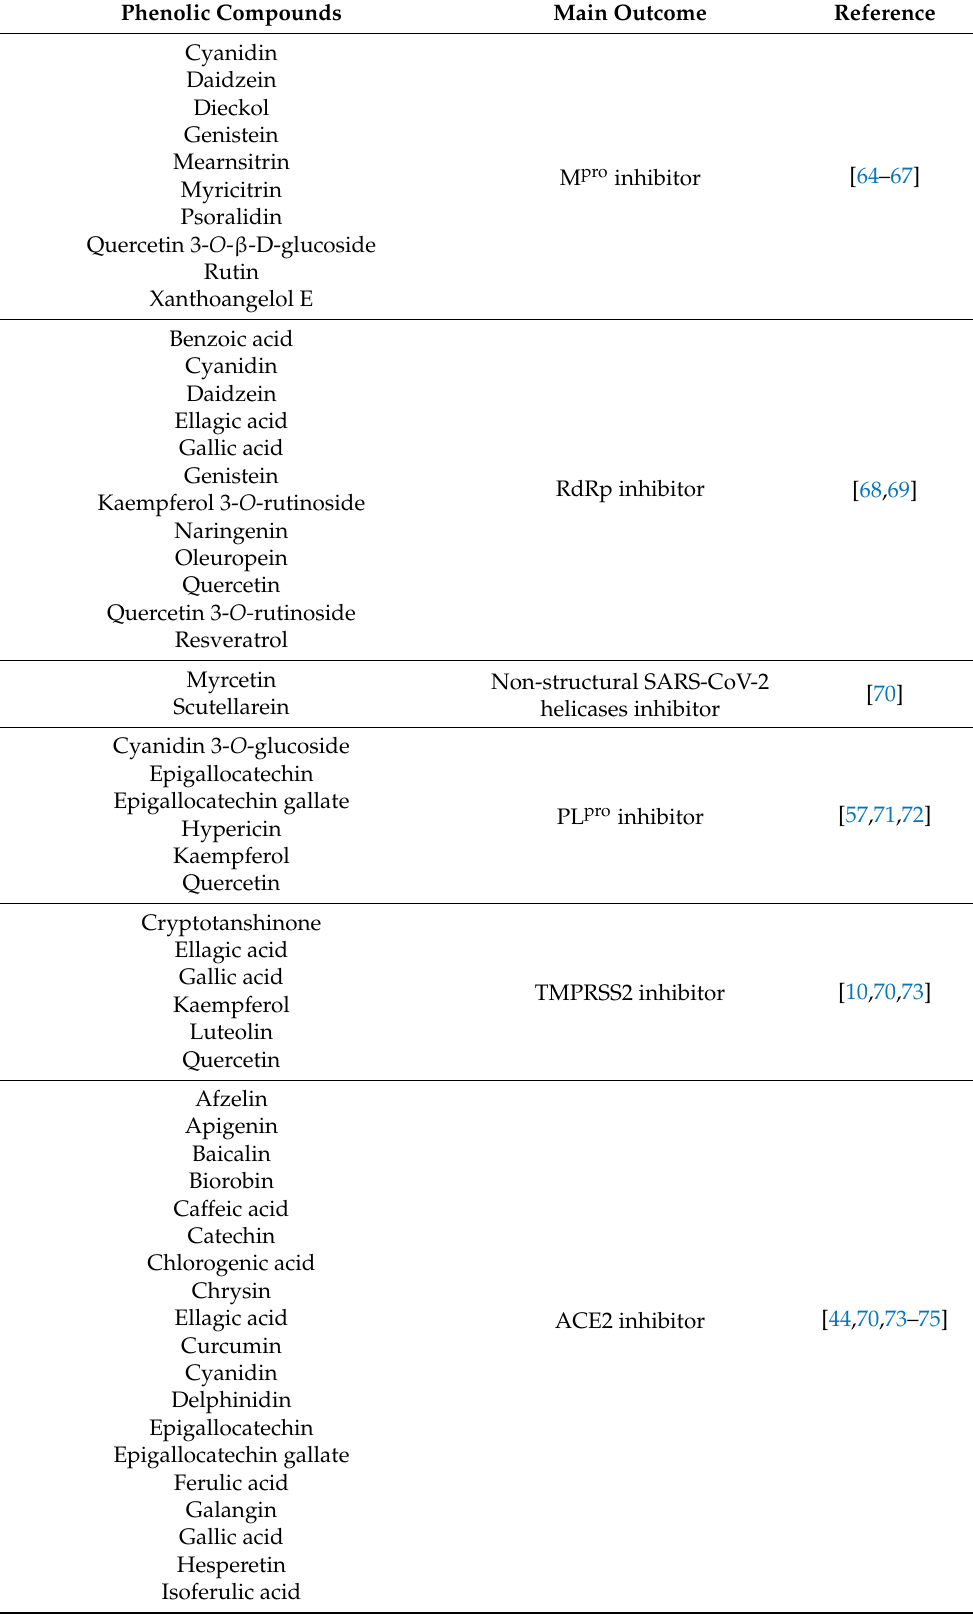
Table 1. Anti-SARS-CoV-2 effects attributed to phenolic